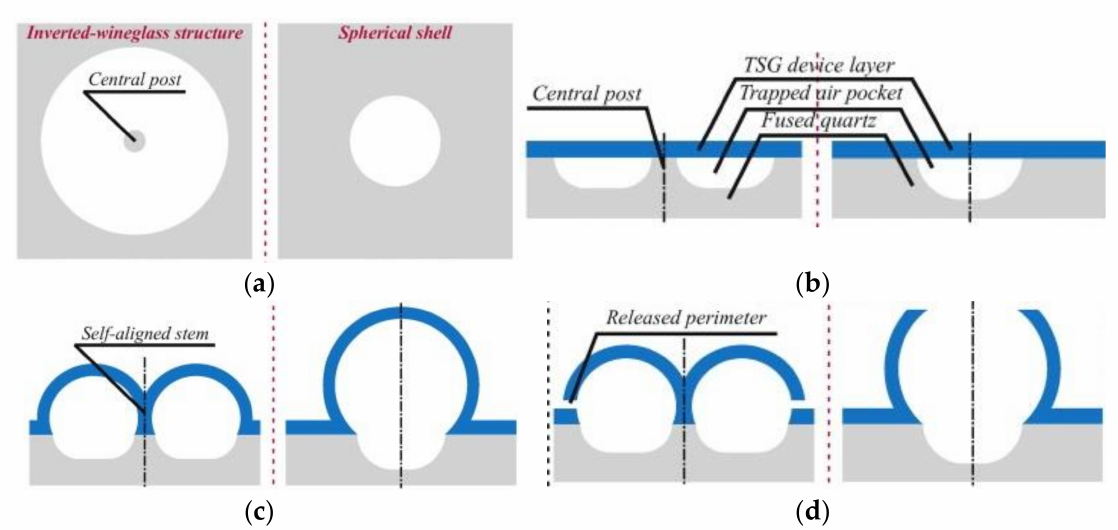
Schematic showing step-by-step process for ULE TSG/fused-quartz-based micro- glassblowing process (Senkal et al. [87]). Reprinted from [87], © (2022), with permission from Elsevier. ( a ) Footprint of the desired geometry is patterned on FS, ( b ) FS is etched and TSG device layer is bonded on top, ( c ) TSG/FS stack is glass blown, ( d ) Wineglass structure is released along the perimeter.